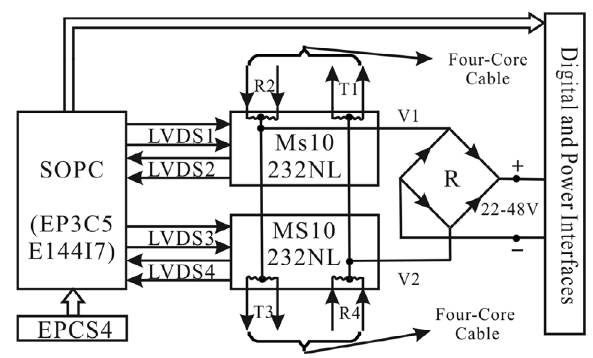
Figure 4. Block diagram of the master data-transmission